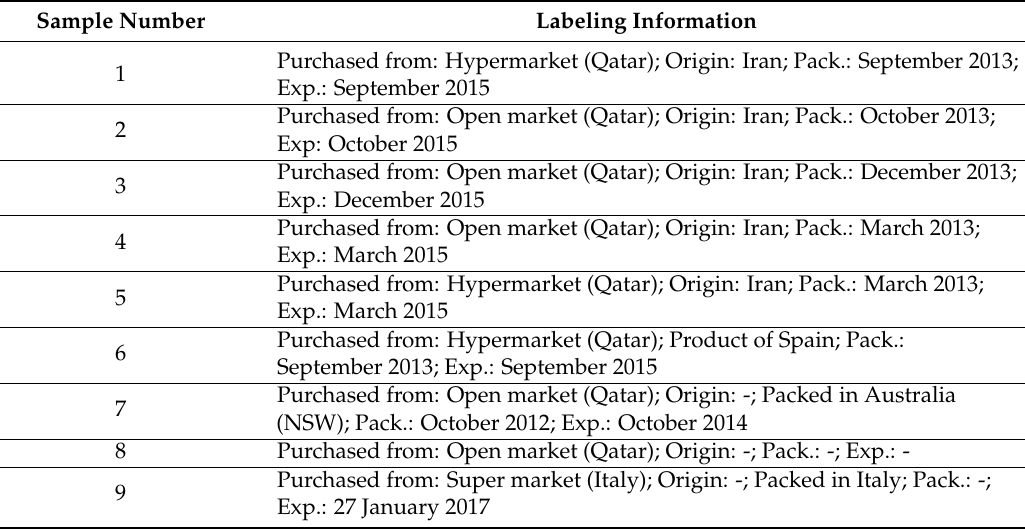
Table 4. Labeling information for the 17 commercial samples under